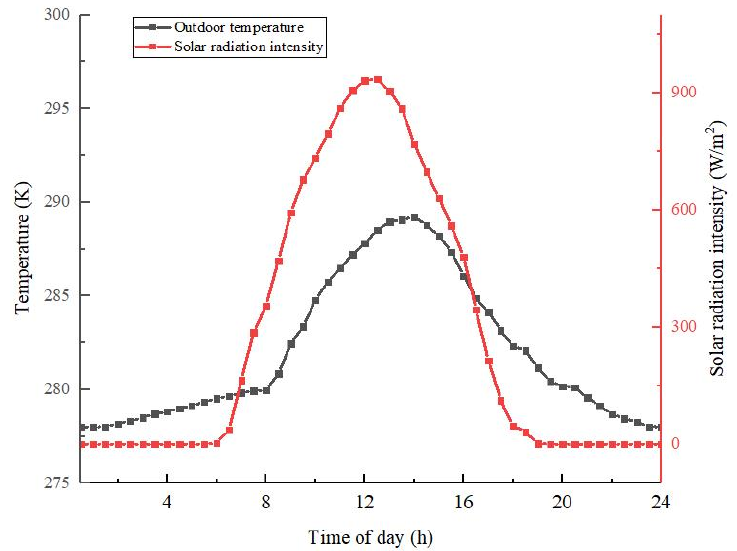
Figure 4. Typical outdoor temperature and solar radiation intensity.